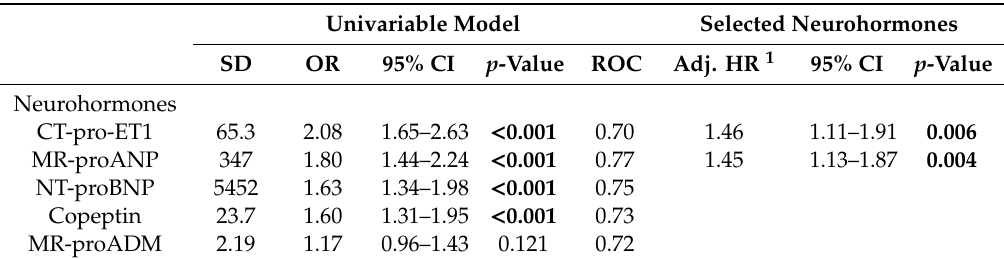
Table 2. Univariable logistic regression analysis assessing risk factors for the presence of severe sTR.